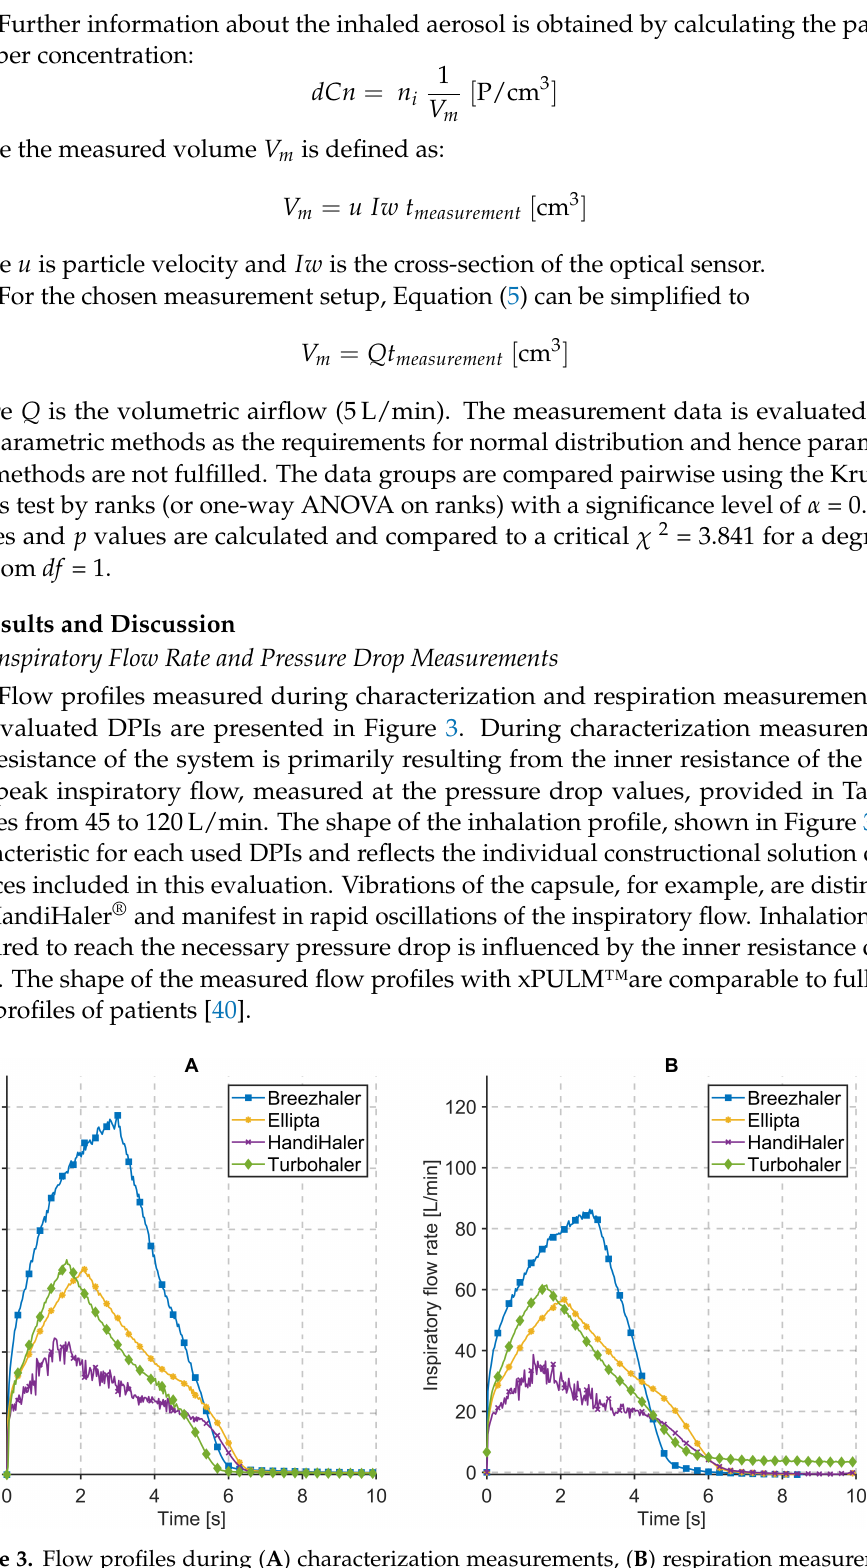
Figure 3. Flow profiles during ( A ) characterization measurements, ( B ) respiration measurements while inhaling through Breezhaler ® , Ellipta ® , HandiHaler ® , and Turbohaler ® at a pressure drop given in Table